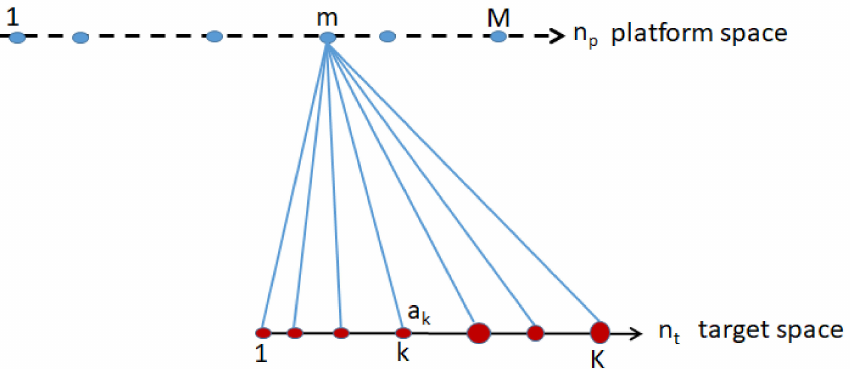
Figure 7. The geometry used in tomographic raw data generation. Blue and red circles represent platforms and targets, respectively, which are both distributed along n . The size of red circles represents the reflectivity of the